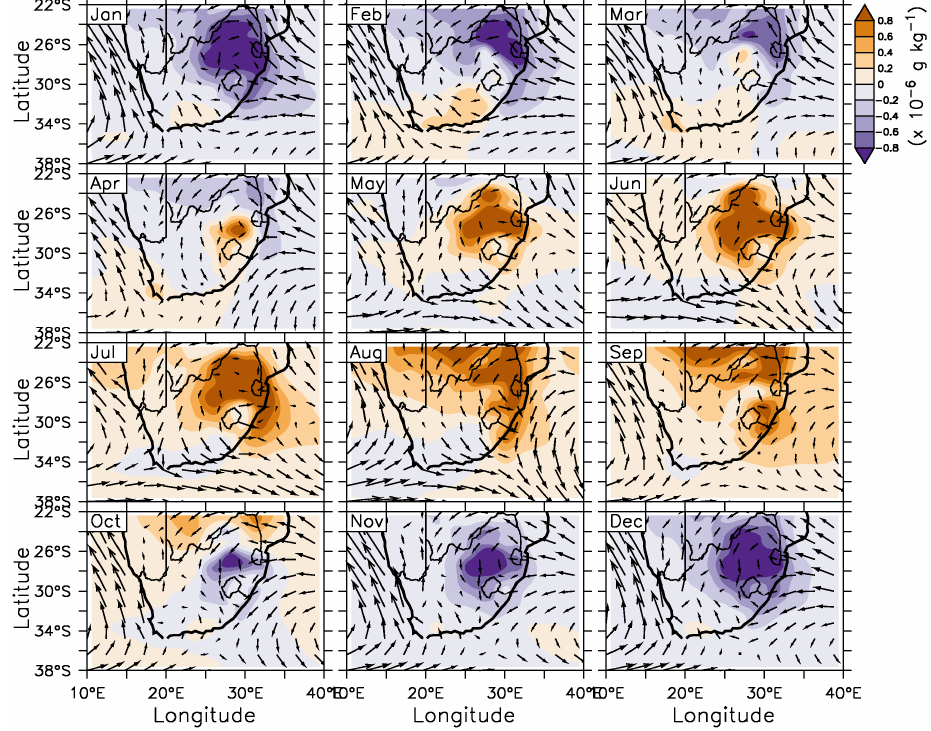
Figure 9: Monthly anomalies of the simulated HNO Fig. 9. Monthly anomalies of the simulated HNO 3 concentration ( × 10 − 6 gkg − 1 ) over South Africa.